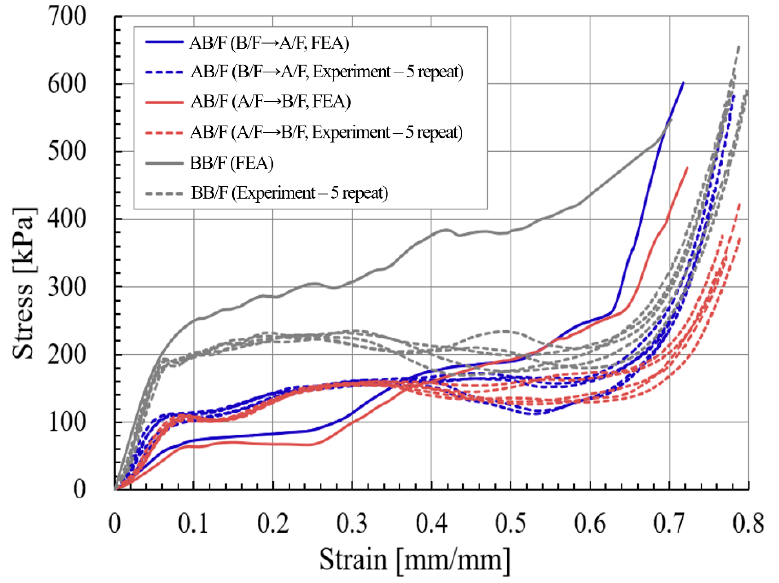
Figure 8. Comparison of the SS curves of the DW corrugated paperboard acquired through experi- ments and FEA.